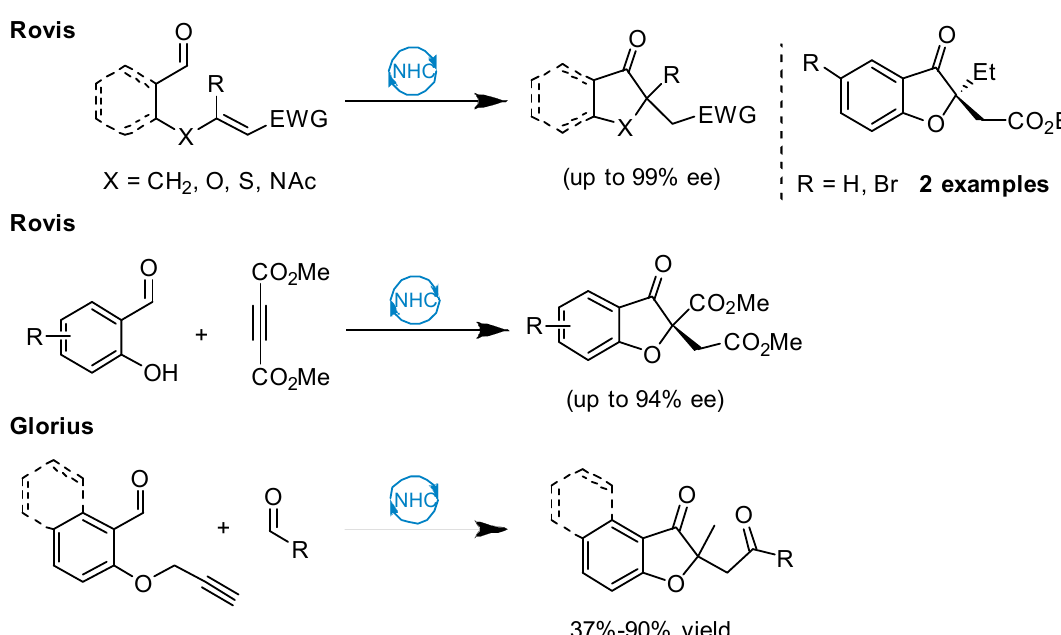
Figure 2. N -heterocyclic carbene (NHC)-catalyzed approach to the 2,2-disubstituted benzofuran-3- ones.